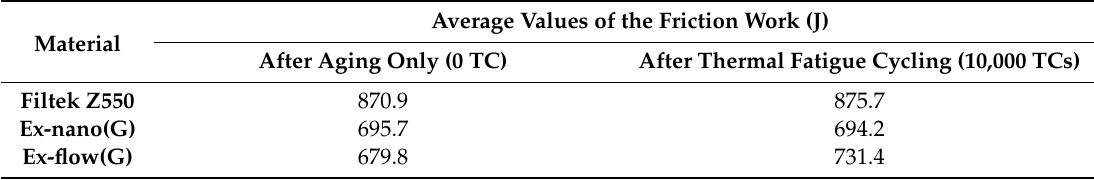
Figure 12. A box-and-whiskers plot of the wear resistance of the N-fill-flow composite. Table 3. Average values of the friction work of the tested materials.